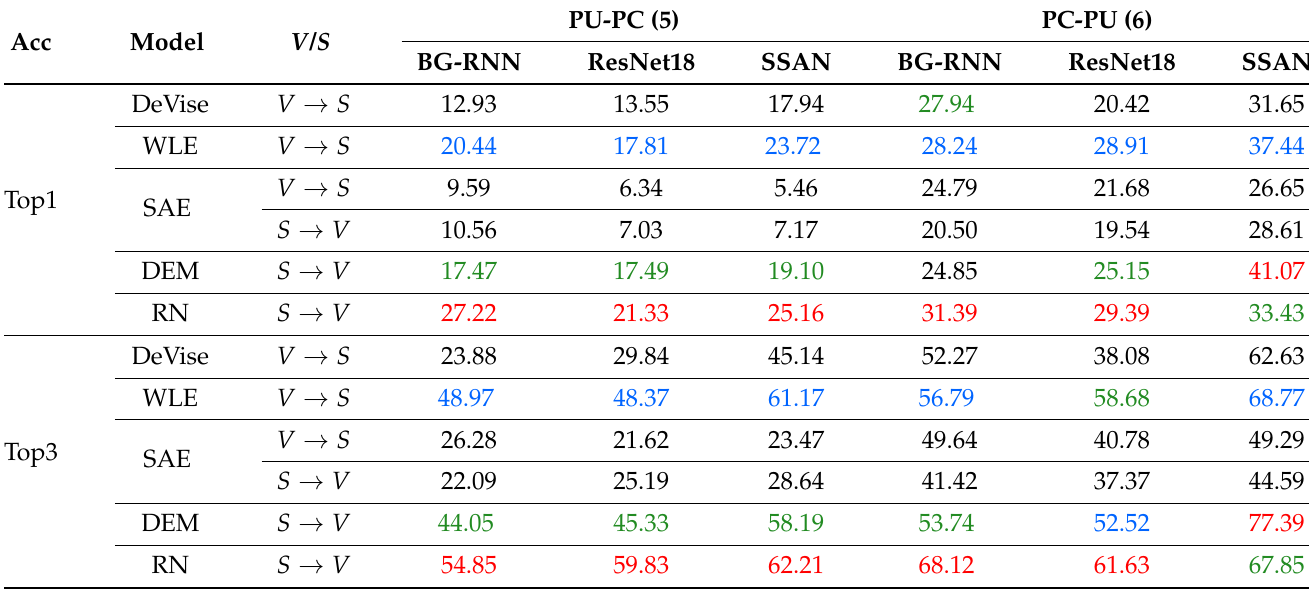
Table 6. Classification performance of multiple comparative methods on GroupB datasets (Case 3 and Case 4) under different visual feature extraction models including the bands-grouping RNN, ResNet18, and SSAN. The best results are shown in red, the blue results represent the second-ranked and the third-ranked results are displayed in green.